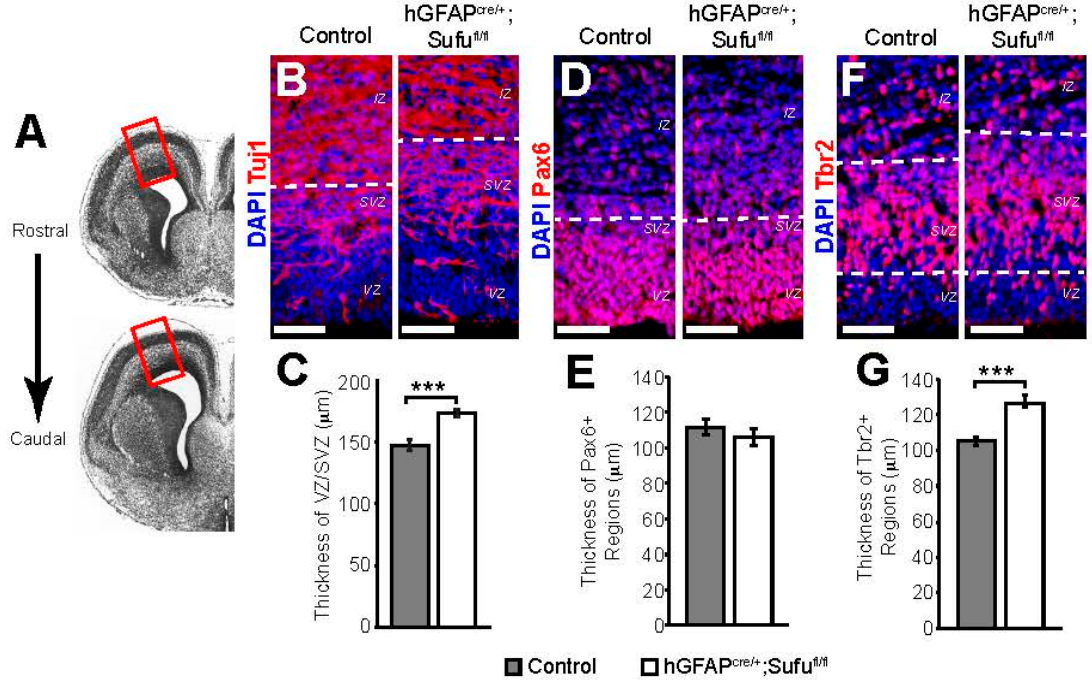
Figure 1. Expansion of the progenitor zones in E16.5 hGFAP cre/+ ;Sufu fl/fl mice. ( A ) The experiments presented here analyzed the dorsolateral region of the neocortex (boxed region), obtained from the rostral forebrain spanning between these representative images; ( B , C ) Targeted deletion of Suppressor of Fused (Sufu) in cortical progenitors at E13.5 ( hGFAP cre/+ ;Sufu fl/fl ) led to the expansion of the VZ/SVZ by E16.5 as defined by immunofluorescence staining. Regions marked by DAPI-dense (blue) cells and reduced Tuj1 (red) immunostaining along the lateral ventricles showed expansion of the hGFAP cre/+ ;Sufu fl/fl VZ/SVZ compared to controls ( B ); The thickness of the VZ/SVZ was determined as the distance between the ventricular lining along the lateral ventricles and the IZ, which was identified by densely packed DAPI+ cells and minimal Tuj1 staining within the dorsolateral neocortex. These measurements confirmed that the hGFAP cre/+ ;Sufu fl/fl VZ/SVZ was significantly thicker than those of control littermates ( C ); ( D , E ) Immunofluorescence staining against the RG cell marker, Pax6 (red), showed no visible differences between the E16.5 control and hGFAP cre/+ ;Sufu fl/fl Pax6+ regions as defined by the dashed lines ( D ); This observation was verified when the thickness of Pax6+ regions was measured ( E ); ( F , G ) Immunofluorescence staining against the intermediate progenitor (IP) cell marker, Tbr2 (red), showed a visible expansion of Tbr2+ regions (between dashed lines) in the E16.5 hGFAP cre/+ ;Sufu fl/fl VZ/SVZ when compared to controls ( F ); Quantification of the thickness of Tbr2+ regions verified these observations ( G ); *** p -value < 0.01. Scale bars = 50 µ m; VZ, ventricular zone; SVZ, subventricular zone; IZ, intermediate zone; DAPI, 4 (cid:48)